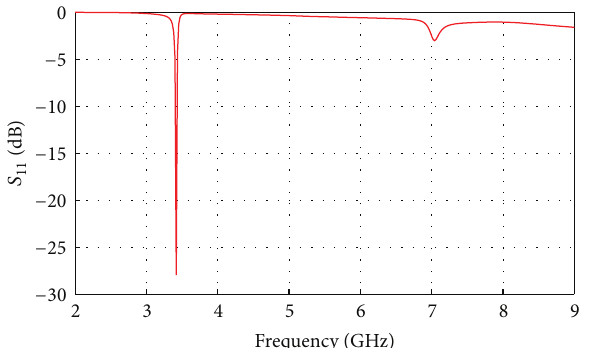
Figure 4: Geometry of (a) the OLR-based bandpass filter and (b) wideband antenna.